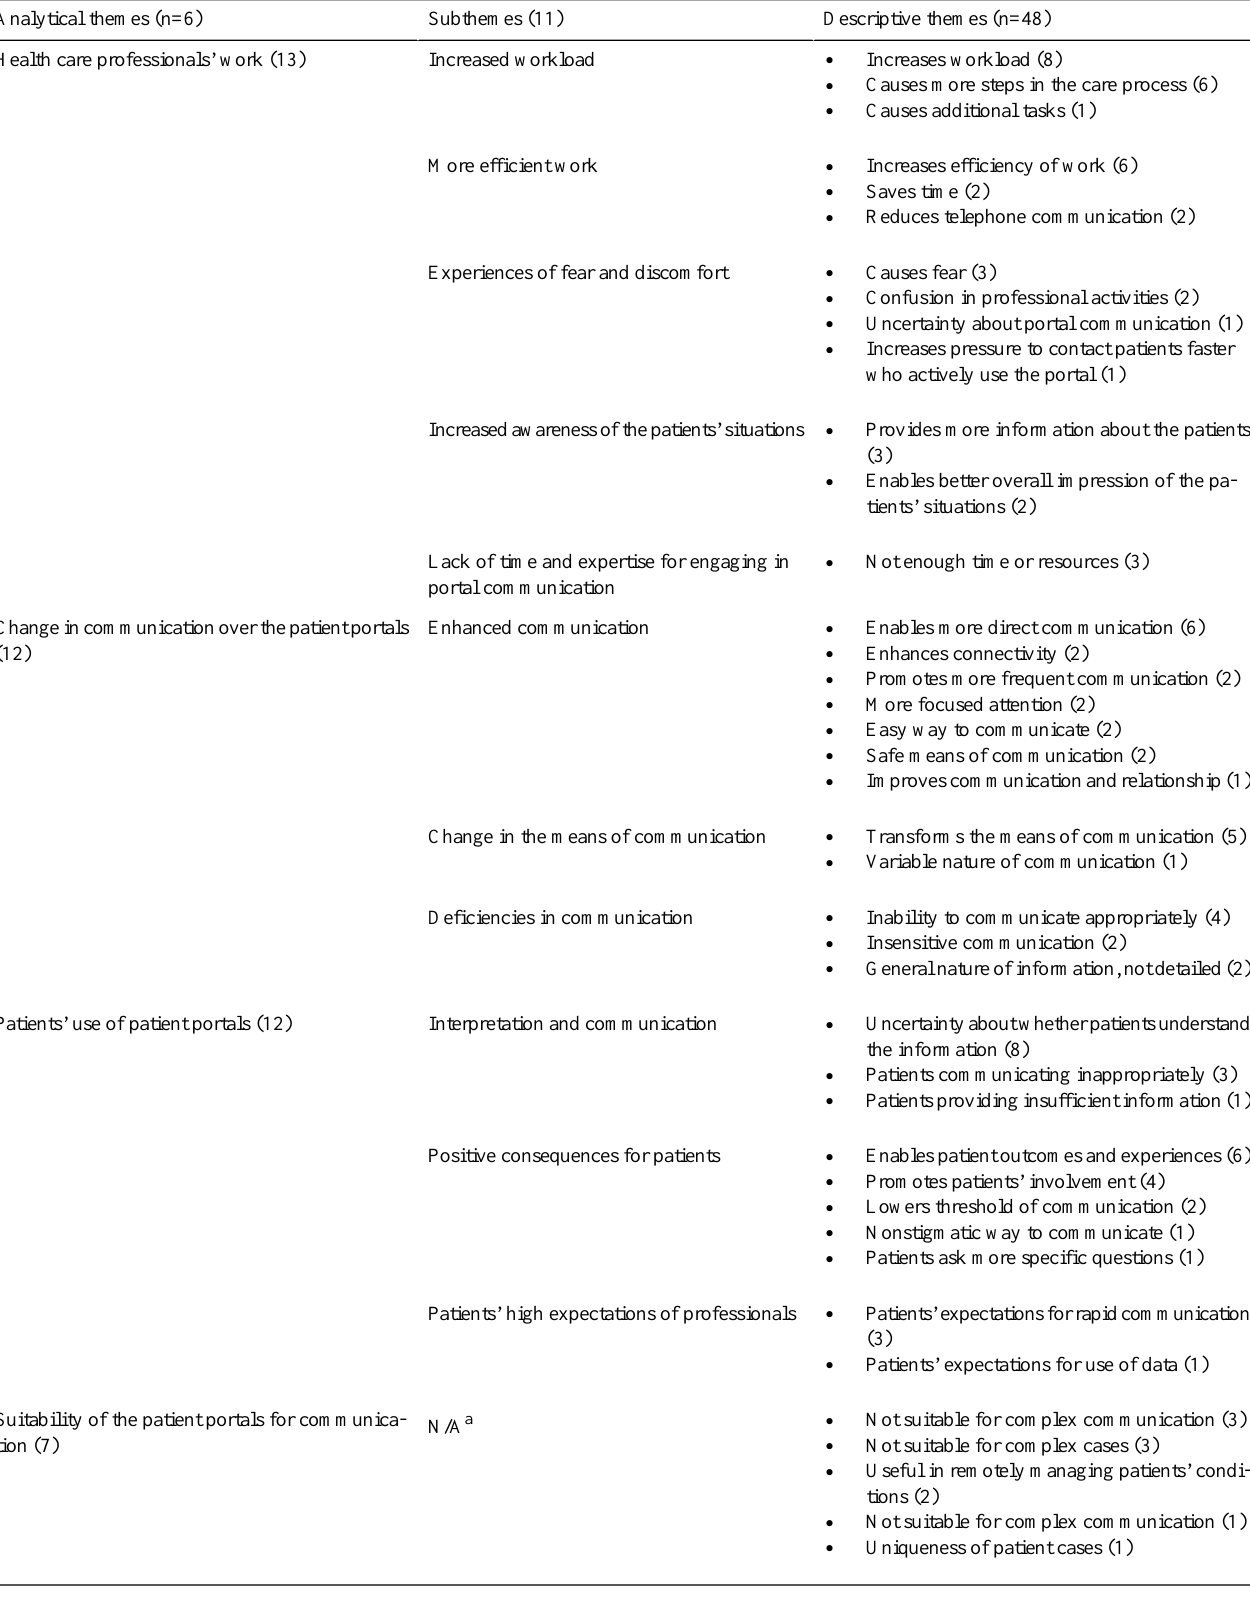
Table 5. An overview of analytical themes, subthemes, and descriptive themes (number of studies out of the included 13).